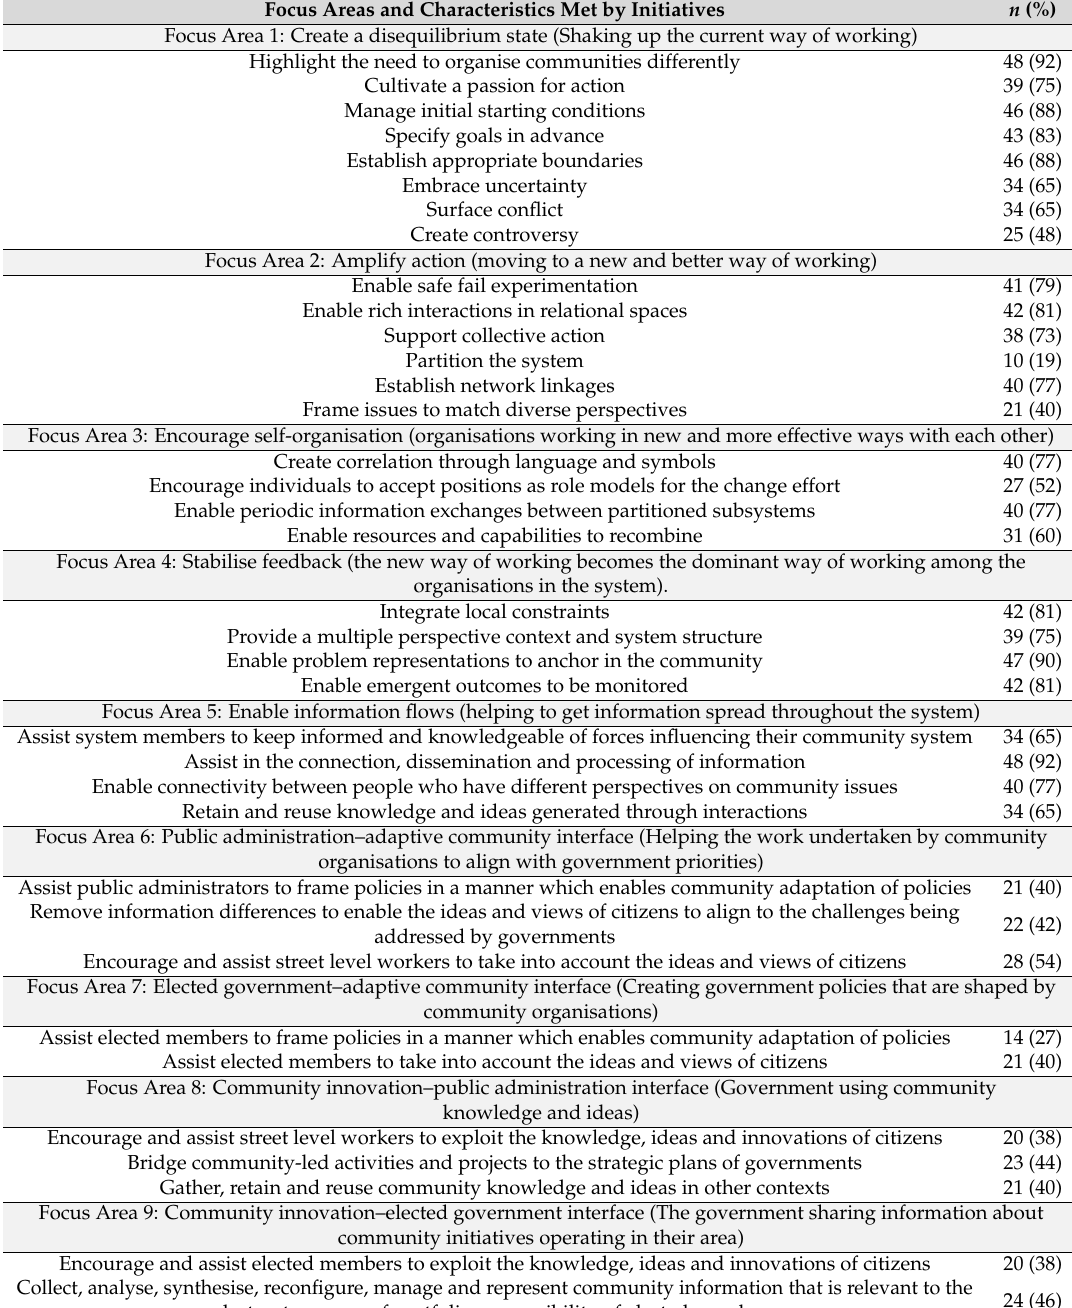
Table 2. Frequency of initiatives meeting Focus Areas and